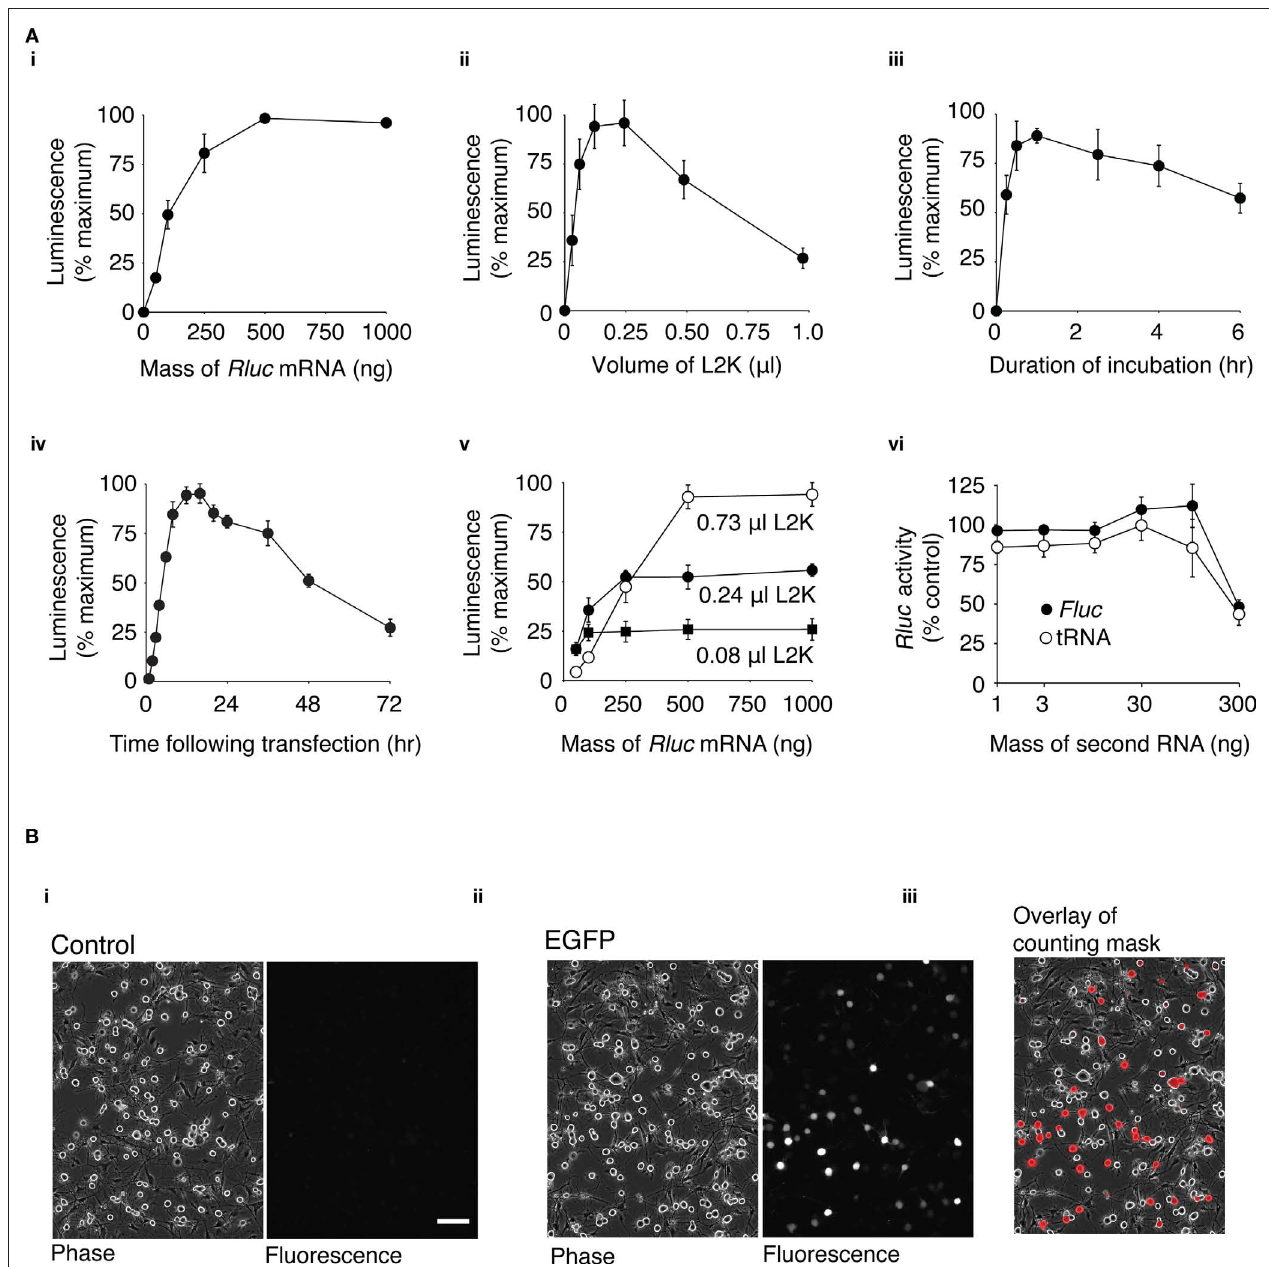
transfection mix containing 30–1000 ng Rluc mRNA and 0.08 μl ( n ), 0.24 μl ( l ), or 0.73 μl ( ¡ ) L2K ( n = 3). (vi) Transfection mix containing 100 ng of Rluc mRNA and 1–300 ng of Fluc mRNA ( l ) or yeast tRNA ( ¡ ). Data was normalized to the luciferase activity of cell lysates transfected with 100 ng Rluc mRNA alone ( n = 3). The points on the graphs represent the mean luciferase activity ± s . e . m . (B) Transfection efficiency of DRG neurons. (i) Phase and fluorescence image of untransfected DRG neurons. (ii) Phase and fluorescence image of DRG neurons transfected with 3.1 μg GFP mRNA, 16 h after transfection (iii) Phase image with overlay of a mask created from the fluorescence image. The mask indicates regions of the image with fluorescence intensities over a threshold above which neurons were classified as transfected (see Methods). 100 μm scale bar (for all